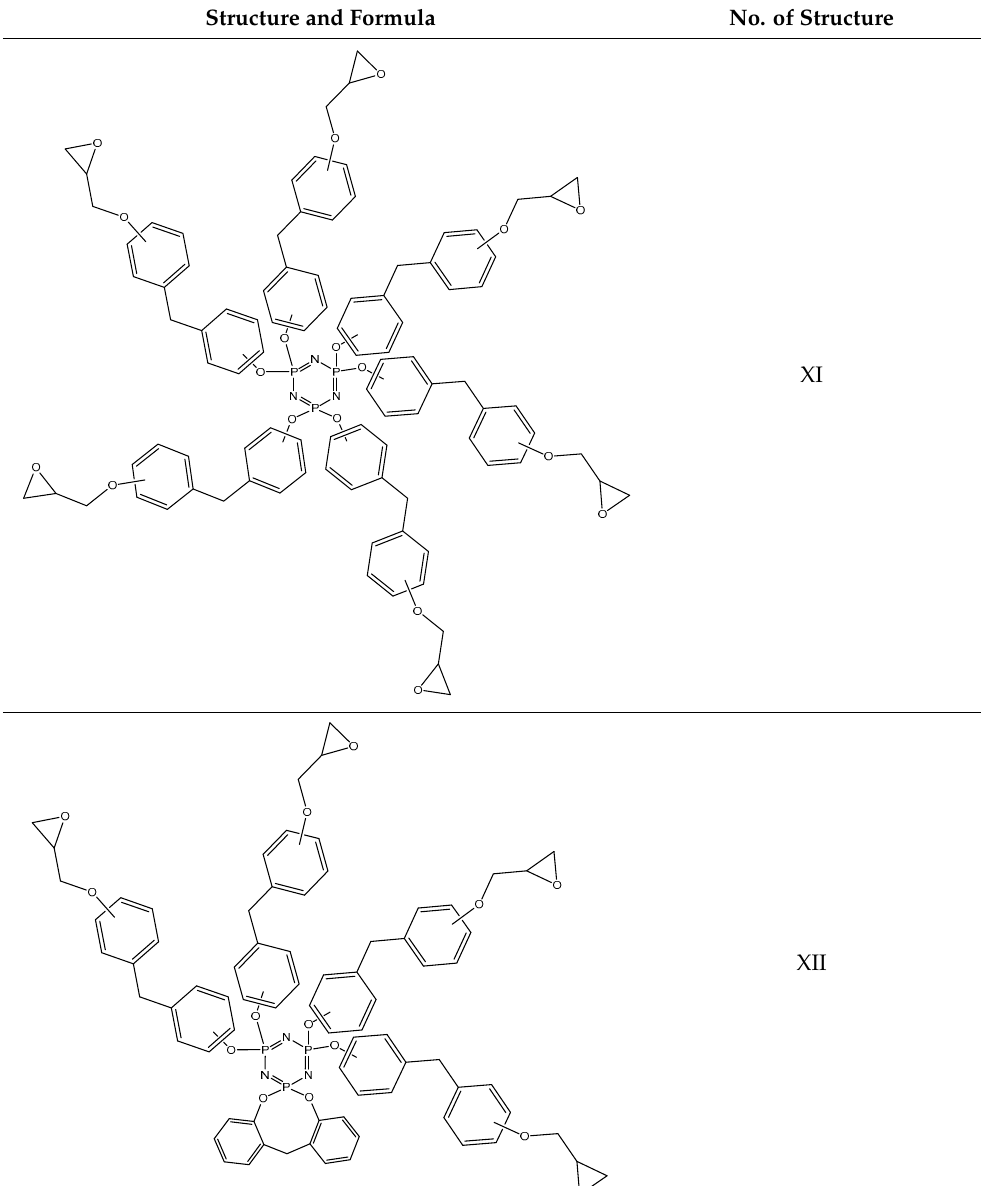
Table 4. Possible structures and formulas of hexa-substituted phosphazenes formed during the syn- thesis of